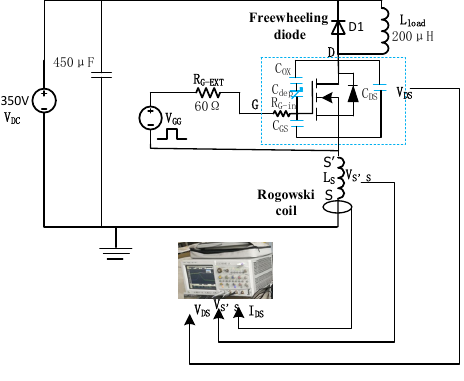
Figure 3. Experimental circuit diagram.